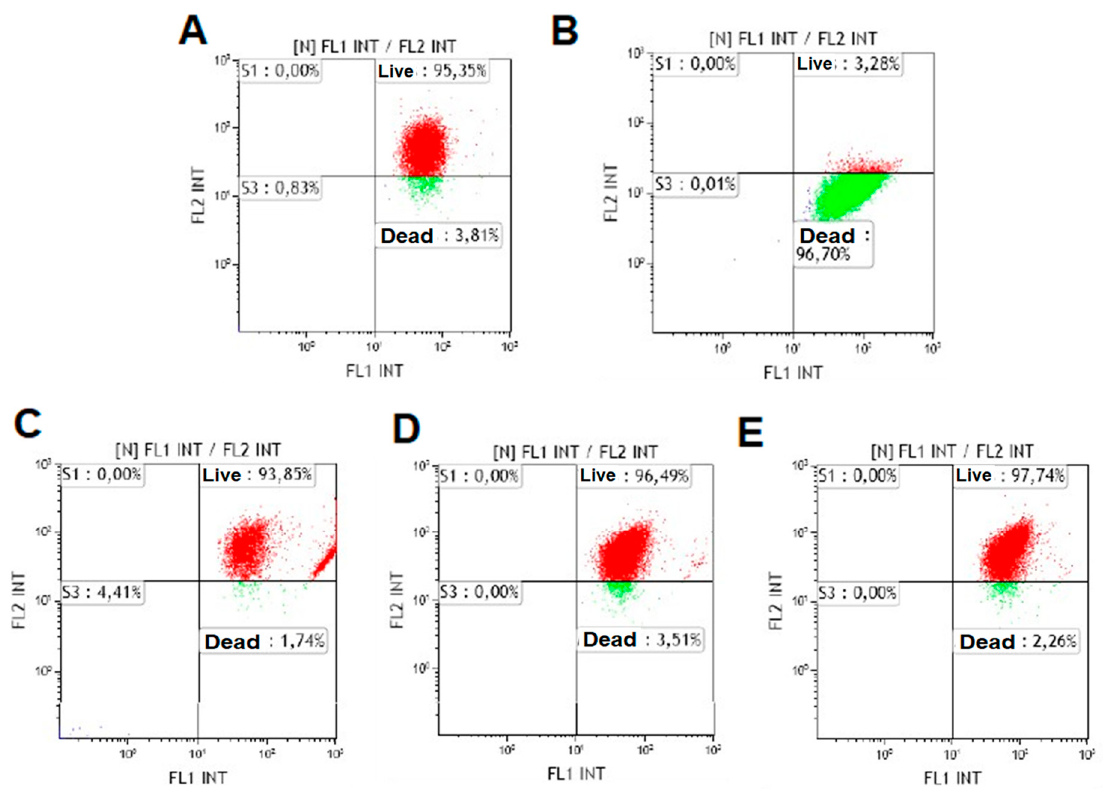
Figure 16. Balance of mitochondrial activity. ( A ) Negative control. ( B ) Positive control. ( C ) SLA. ( D ) HA + AW. ( E ) HA/TCP.